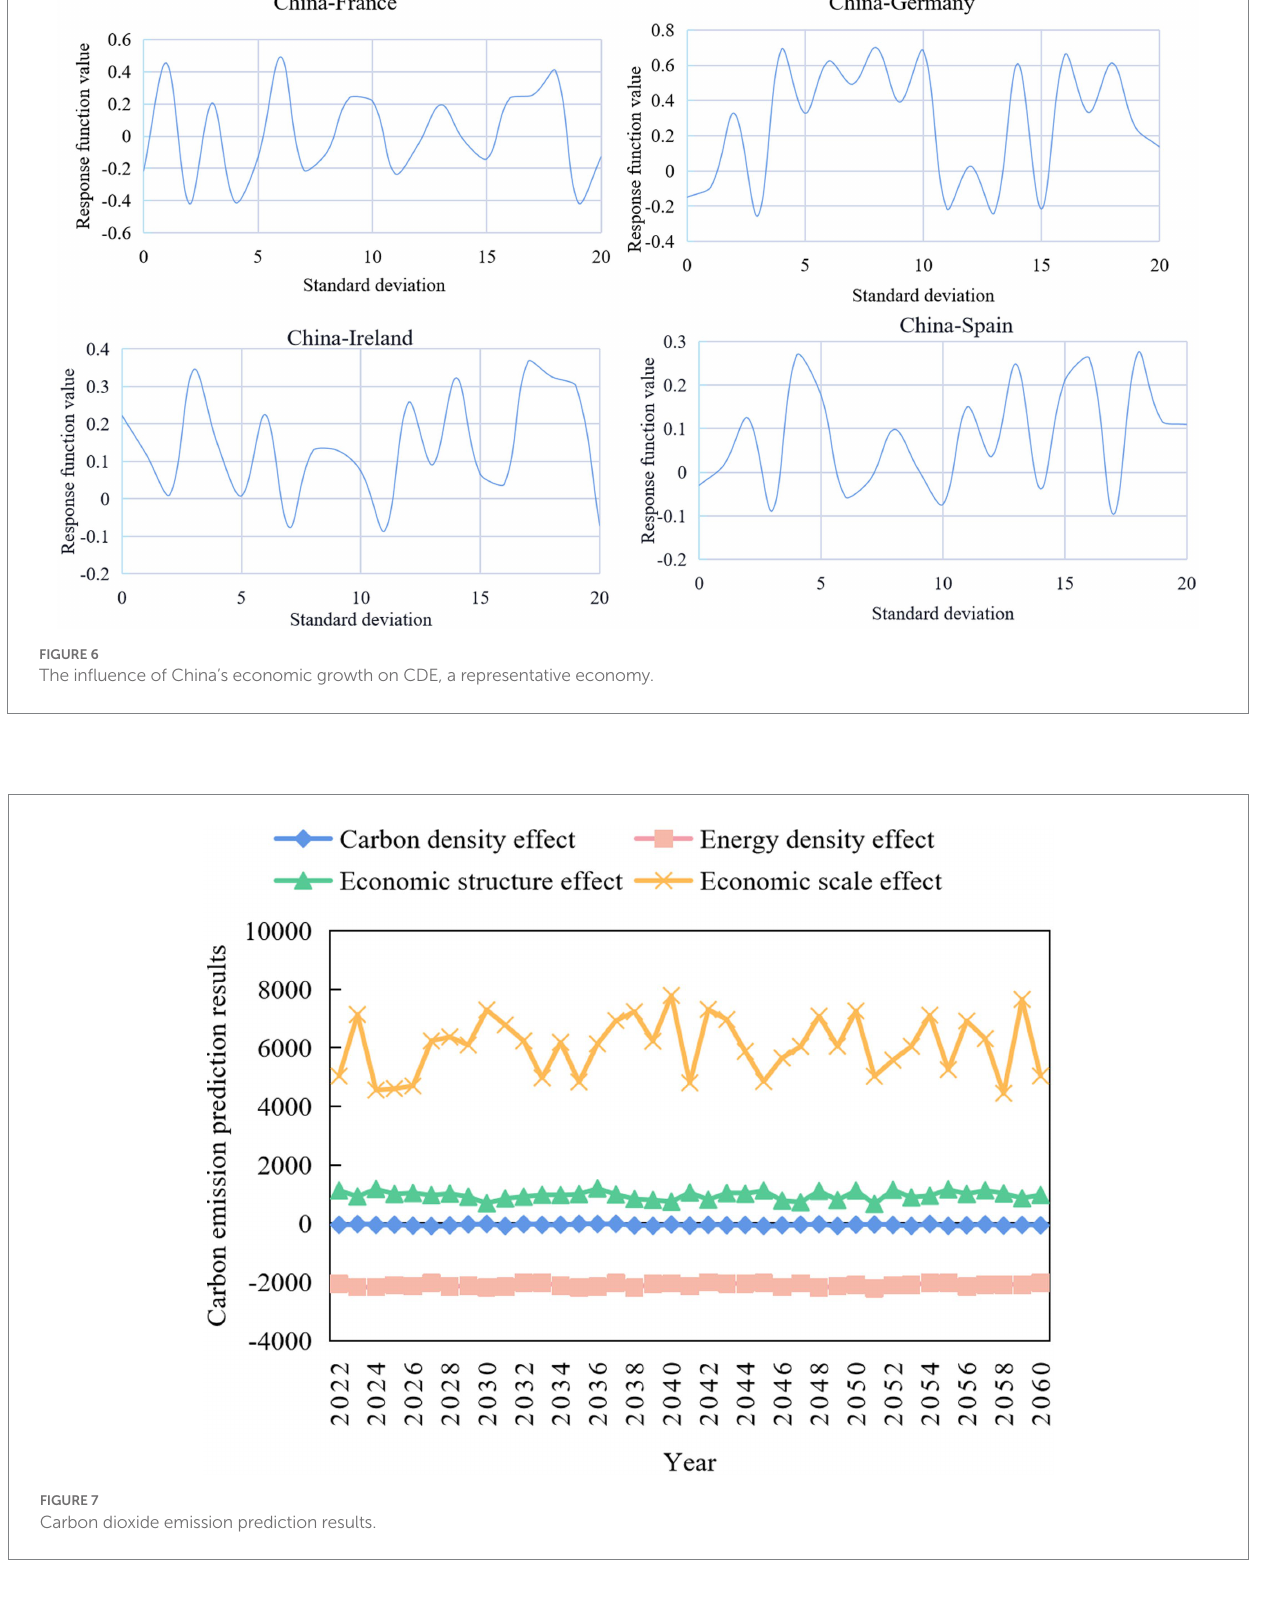
However, if the industrial sector develops at a growth rate of 7%, China will not be able to achieve the emission reduction target by 2023. It shows that China has dramatically improved its technical